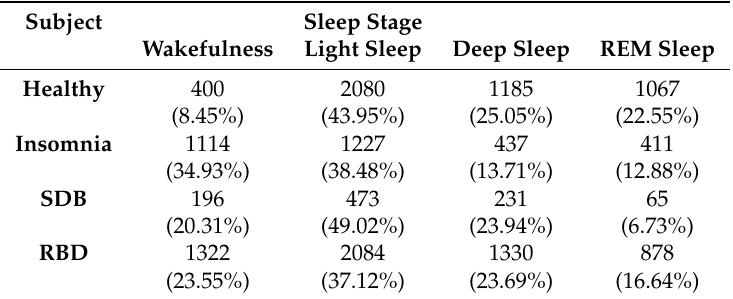
Figure 1. General scheme of the proposed method for automatic sleep disorders classification. Table 1. Detailed information about the total number of